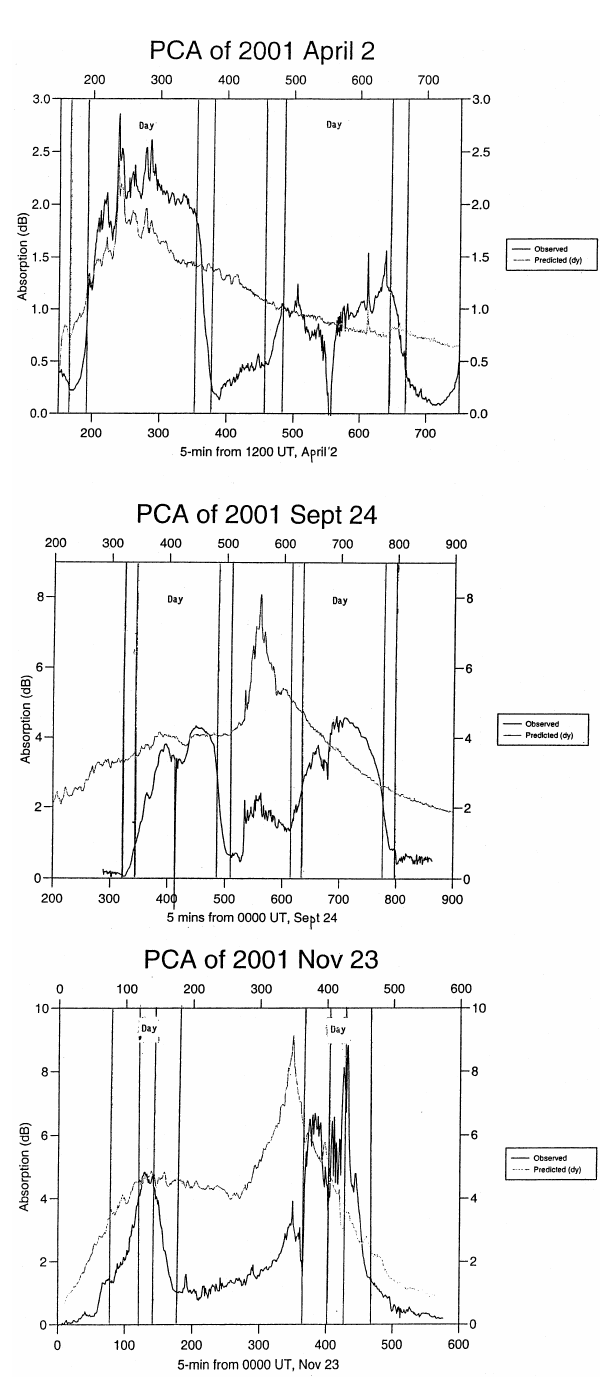
Fig. 9. Predicted absorption for the daytime periods of the PCA events of 2001 starting 2 April, 24 September, and 23 November. The vertical lines mark the limits assumed for day and night: solar elevation angles 0 and − 10 ◦ respectively. The severe dip on the second day of the April event was caused by a burst of solar radio noise.